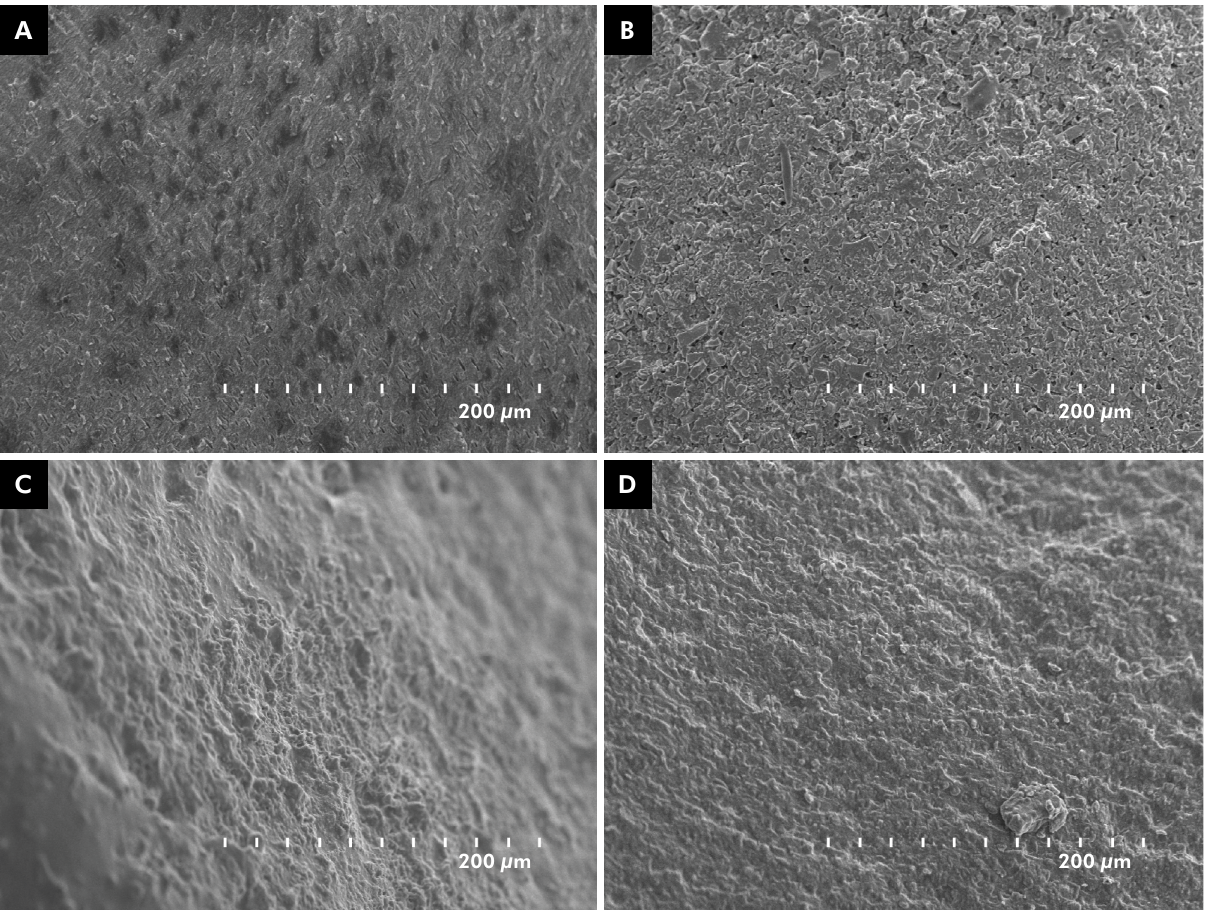
Figure. (a) SEM image of the surface of control specimen; (b) SEM image of the surface of chitosan-modified material specimen; (c) SEM image of the surface of nanodiamond-modified material specimen; (d) SEM image of the surface of chitosan-nanodiamond- modified material